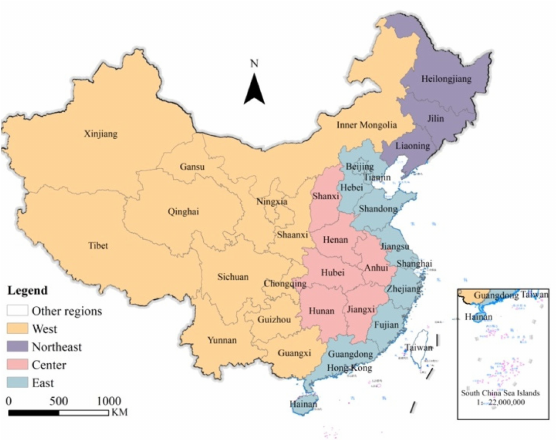
Figure 1. Analysis framework.